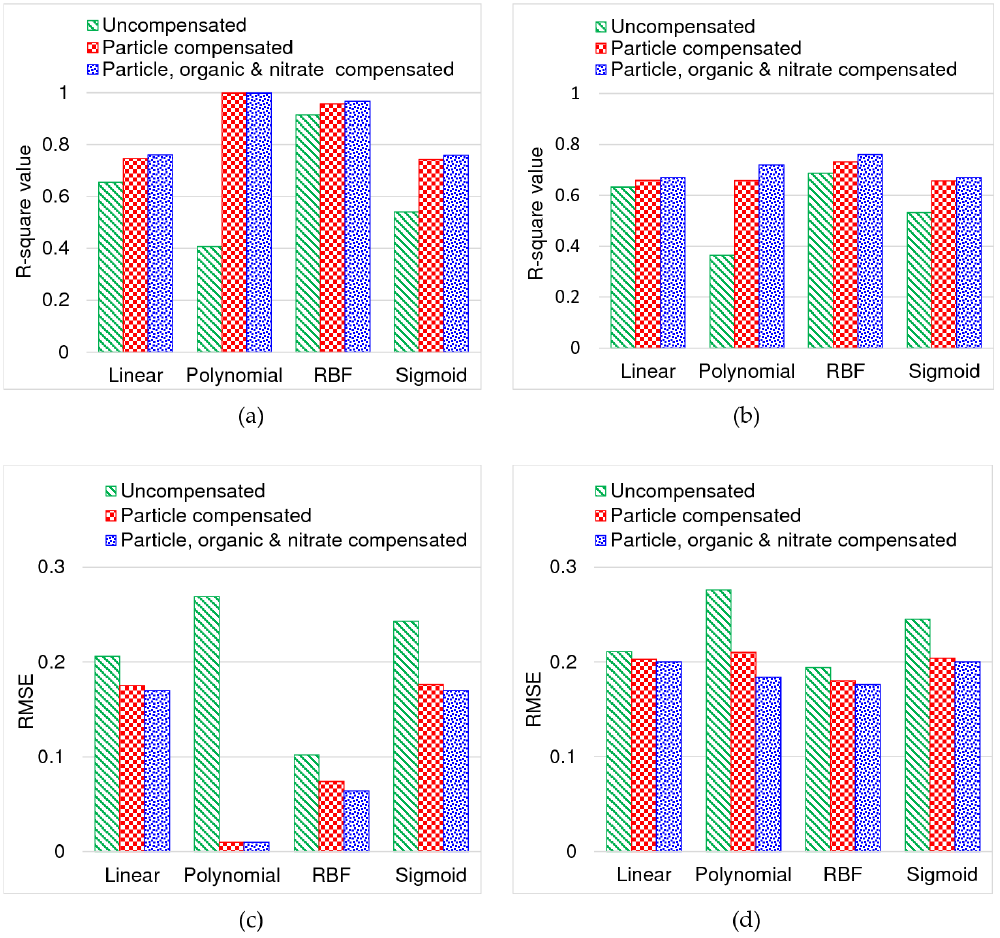
Figure 11. Comparison of SVR modelling performance: ( a ) R-square in model training, ( b ) R-square in cross-validation, ( c ) RMSE in model training, and ( d ) RMSE in cross-validation.